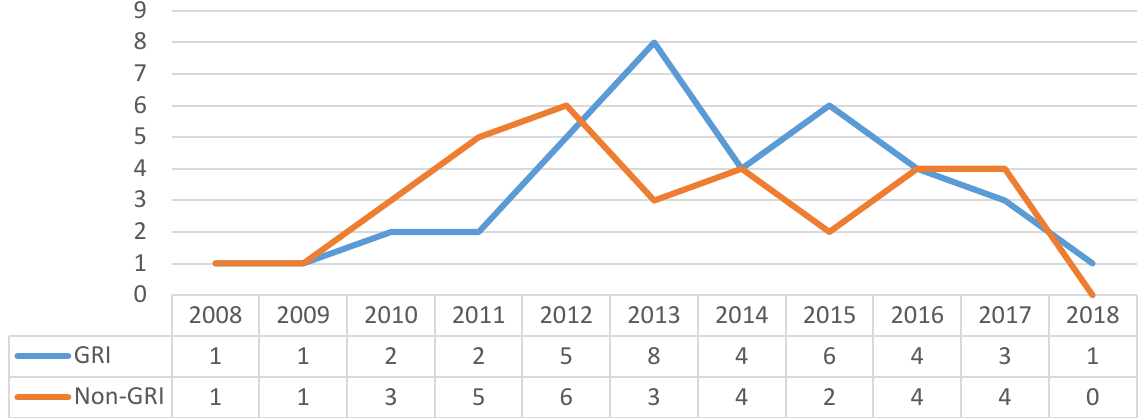
Figure 3. Standards for preparation sustainability